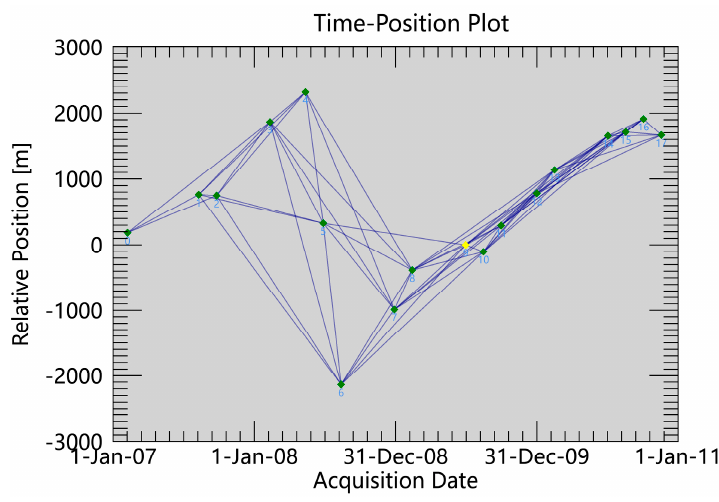
Figure 10. Time-Position map of ALOS PALSAR ascending data.